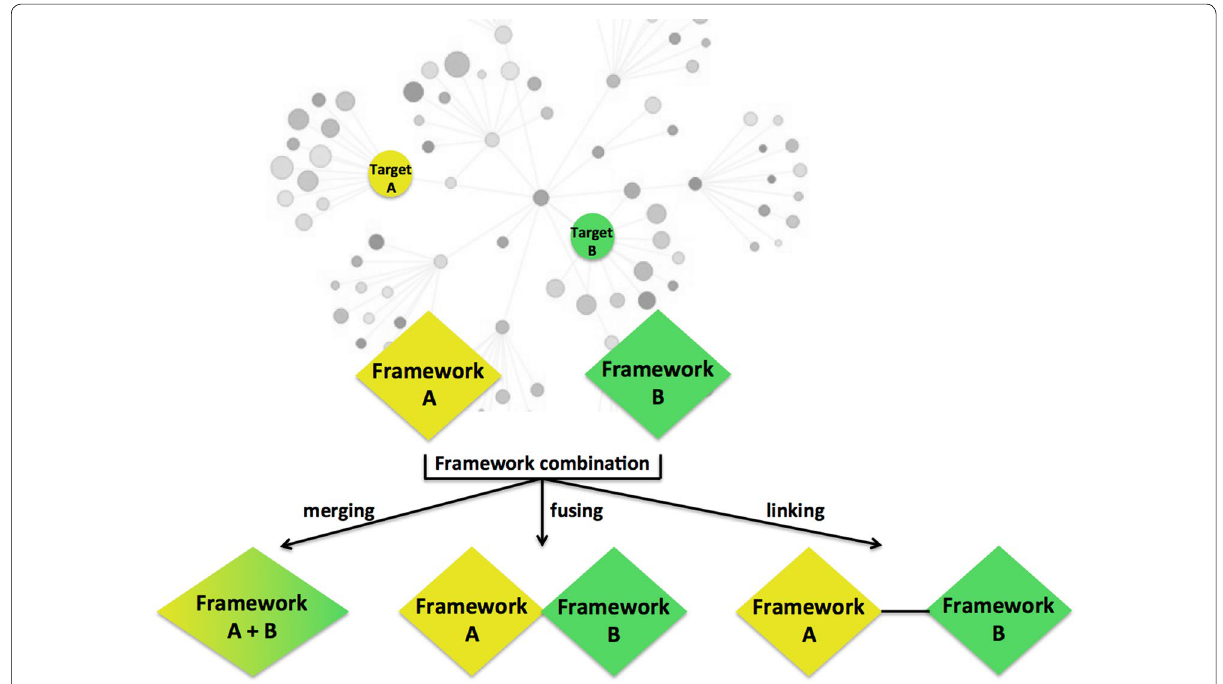
Fig. 3 Rational design of multi‑target